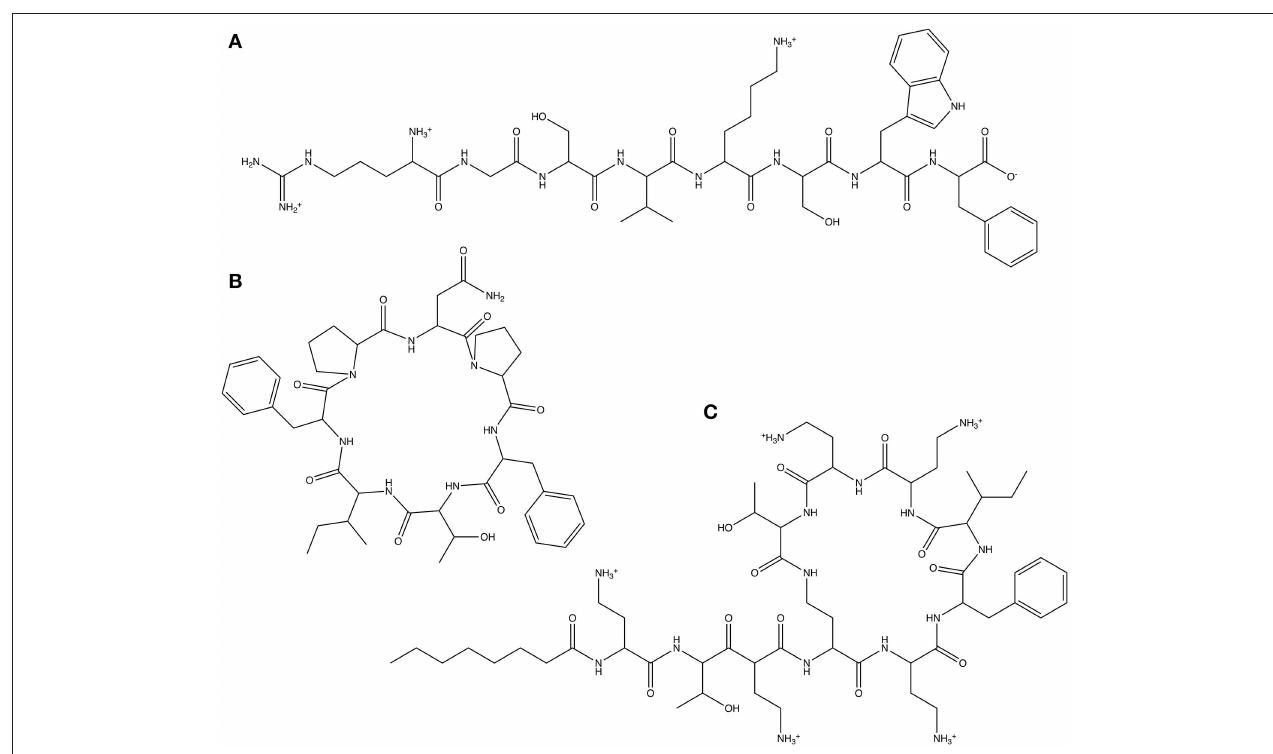
FIGURE 4 | The three peptides used to illustrate the performance of CherryPicker using user-specified and automatically-generated Athenaeums. (A) The randomly generated amino acid sequence Arg-Gly-Ser-Val-Lys-Ser-Trp-Phe, (B) the cyclic peptide Axinellin A, which has the amino acid sequence cyclo(Asn-Pro-Phe-Thr- Ile-Phe-Pro), (C) the non-ribosomal cyclic lipopeptide Polymyxin B3, which has the amino acid sequence octanoyl-Dab-Thr-Dab-Dab(1)-Dab- D -Phe-Leu-Dab-